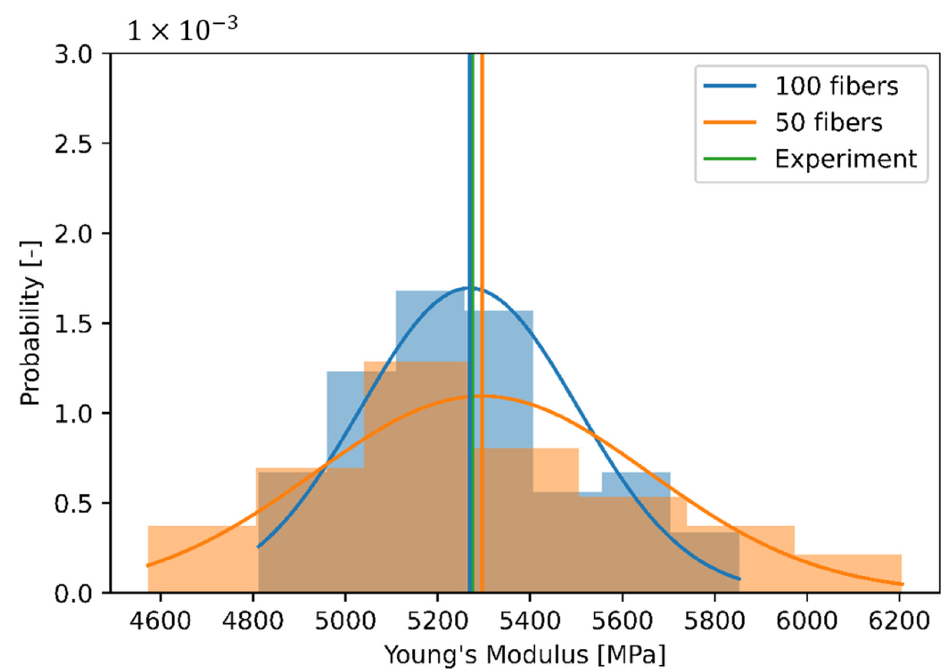
Figure 9. Histogram and normal distribution of the effective stiffness, calculated with 50 and 100 fibers using the SVE approach.